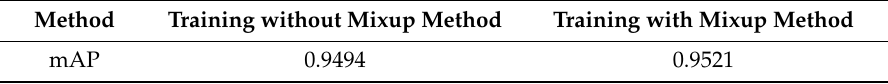
Table 9. mAP results for two different situations.